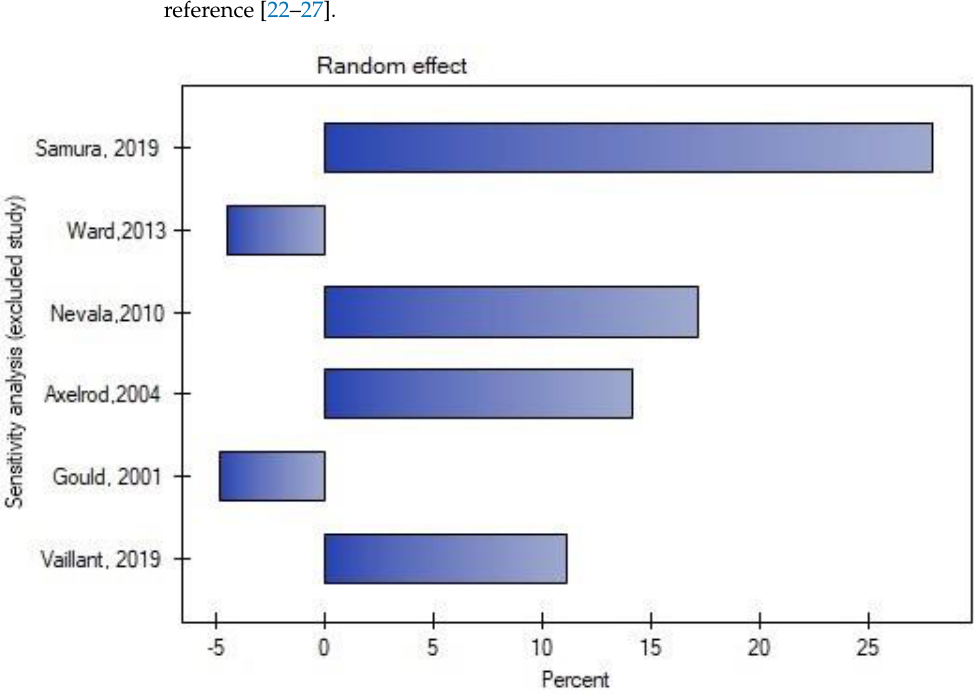
Figure 4. Leave-one-out meta-analysis for the occurrence of type II endoleak. Data referred from reference [22 – 27].